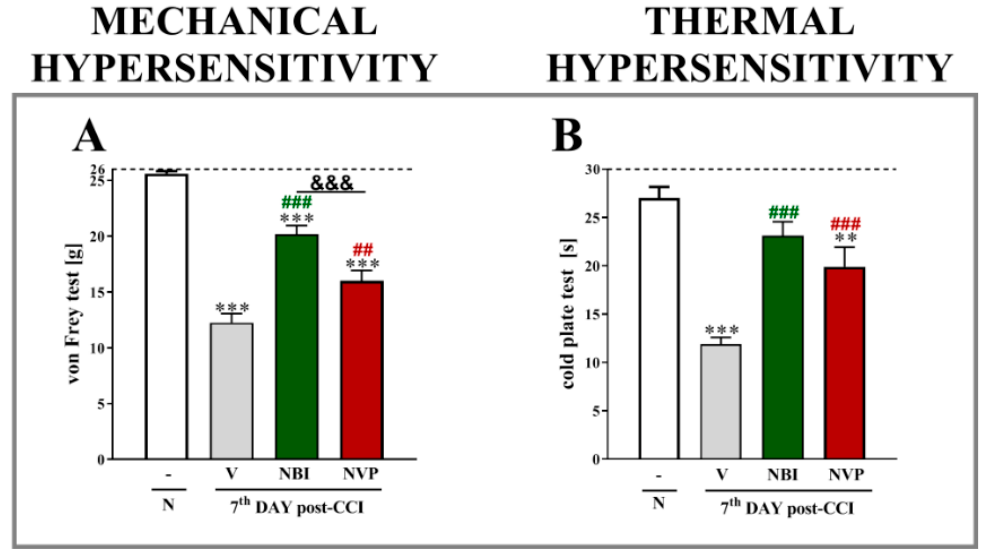
Figure 2. Comparison of the analgesic effects of repeated intrathecal ( i.t .) administration of ( ± )-NBI 74330 and NVP CXCR2 20 (10 µg/5 µL, each; ( A , B )) on the 7th day after chronic constriction injury in rats. The effects of repeated i.t. NBI and NVP injection on mechanical ( A ) and thermal ( B ) hypersensitivity were measured at 120 and 125 min after the last drug administration, respectively. The data are presented as the means ± SEM (10 rats per group), and the horizontal dotted line shows the cutoff value. The results were evaluated using one-way ANOVA followed by Bonferroni’s test. ** p < 0.01 and *** p < 0.001 for the comparison of naive animals with all groups. ## p < 0.01 and ### p < 0.001 for the comparison of vehicle-treated animals with all groups. &&& p < 0.001 for the comparison of animals treated with NBI or NVP. Abbreviations: naive, N; vehicle, V; (±)-NBI 74330, NBI; NVP CXCR2 20, NVP.